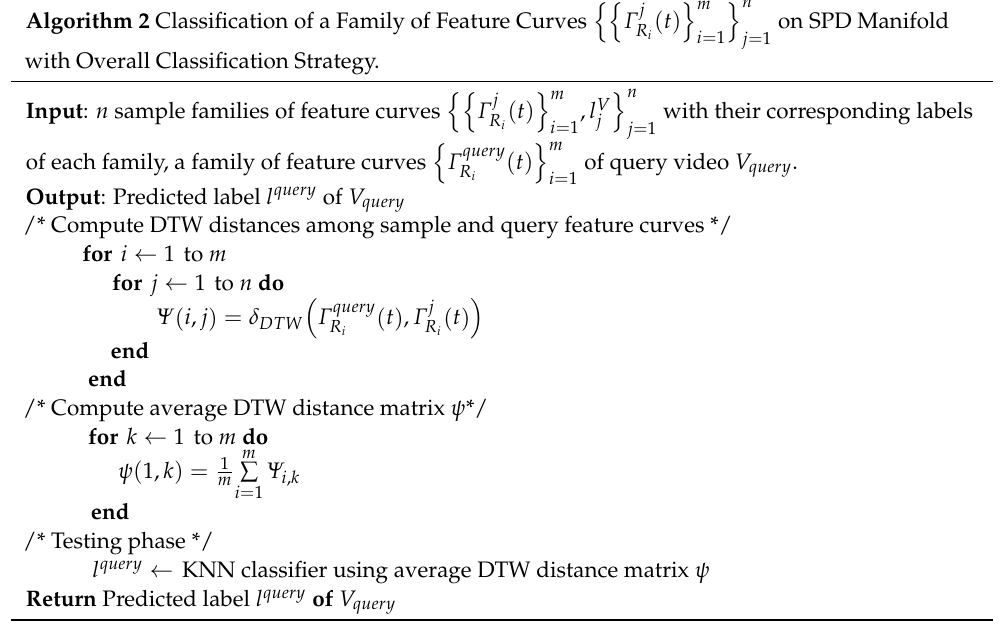
(cid:110)(cid:110) (cid:111) n (cid:111) m ( t ) Γ j on SPD Manifold R i i = 1 j = 1